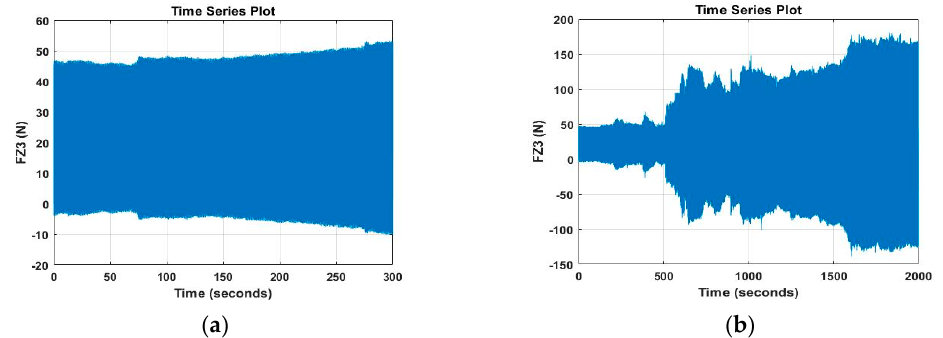
Figure 13. Force transmission results for bracket unit from GUI: ( a ) results for case I; ( b ) results for case II.